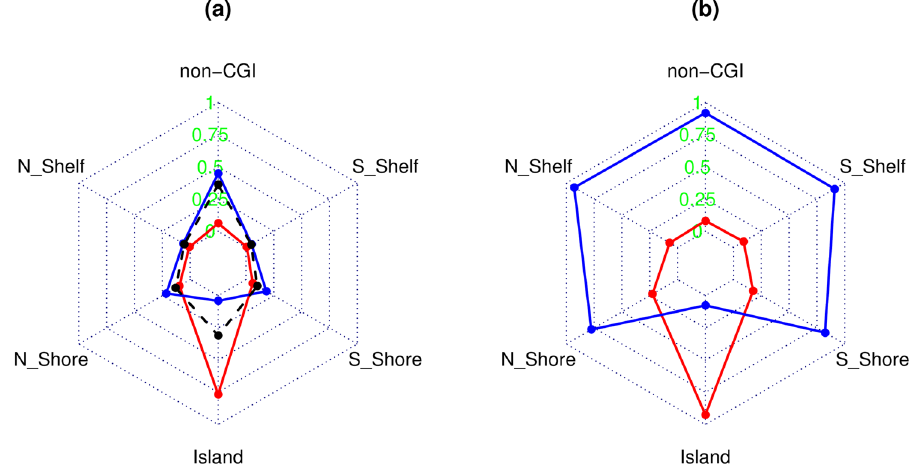
Figure 3. Starplots showing ( a ) proportionality of locations in relation to CpG island for the age-methylation (red) and demethylation (blue) CpGs; and ( b ) location-specific proportion of age-methylated (red) and demethylated (blue) CpGs in all double-replicated CpGs in the location.